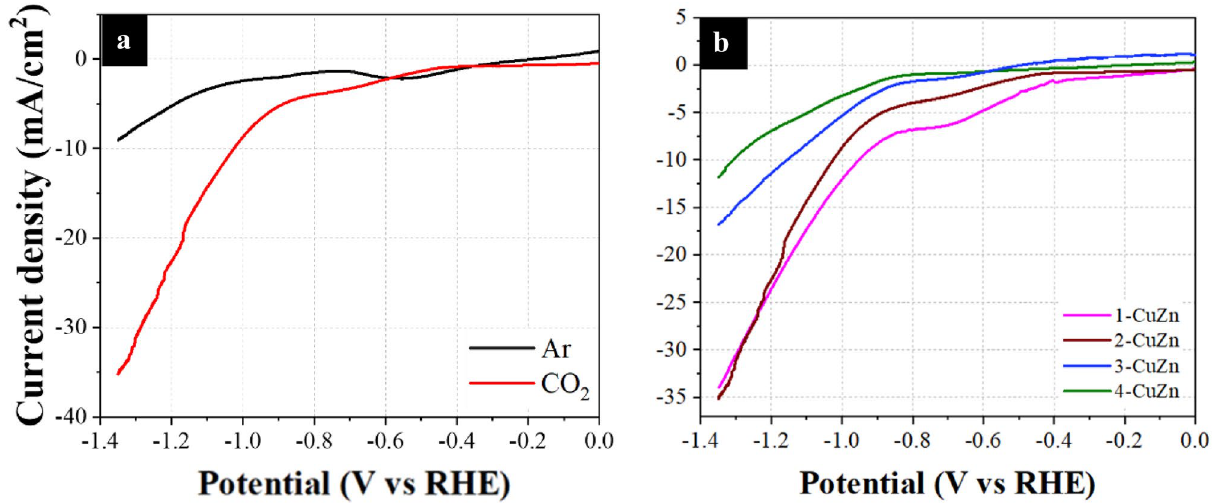
Figure 2. Linear scan voltammetry under continuous CO 2 and Ar purge in 0.5 M KHCO 3 and 0.5 M Na 2 SO 4 , respectively for samples ( a ) 1-CuZn, ( b ) 2-CuZn, ( c ) 3-CuZn, and ( d ) 4-CuZn.